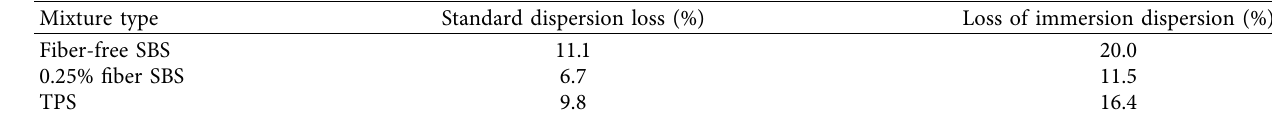
Table 15: Flight test results.